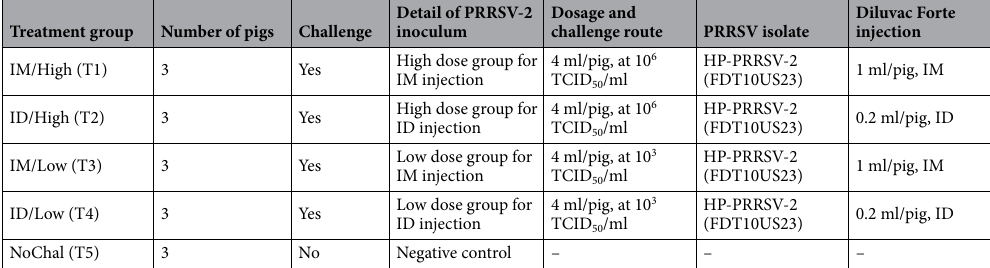
Table 2. Twenty-seven remaining pigs were left as non-challenge, age-matched sentinel pigs. Two different dos- ages of HP-PRRSV-2 were used to inoculate pigs. The IM/High (T1) and ID/High (T2) groups were intranasally inoculated with 4 ml (2 ml/nostril) of HP-PRRSV-2 (FDT10US23 isolate, 10 6 TCID 50 /ml). The IM/Low (T3) and ID/Low (T4) groups were intranasally inoculated with 4 ml of HP-PRRSV-2 at a lower dose (FDT10US23 isolate, 10 3 TCID 50 /ml). The NoChal (T5) group was served as a control, and the remaining 17 pigs were used as age-matched sentinel pigs. Sera were collected at 0, 7, 14, 21, and 28 DPC and assayed for the presence of PRRSV-specific antibody and RNA using ELISA and qPCR, respectively. To mimic vaccine administration, Diluvac Forte, an adjuvant, was used instead of a vaccine. At 7 DPC, the IM/High (T1) and IM/Low (T3) groups were IM injected with 1 ml of Diluvac Forte (batch no G197A01, MDS Animal Health, Boxmeer, The Netherlands) using a conventional needle (G18, 1 ″ ). The ID/High (T2) and ID/ Low (T4) groups were ID injected with 0.2 ml of Diluvac Forte using IDAL 3G needle-free vaccinator (MSD Animal Health, Boxmeer, The Netherlands). The same conventional needles or needle-free device were used to inject the same volume of Diluvac Forte (MSD Animal Health, Boxmeer, The Netherlands) to sentinel pigs with the same route of injection. The same device that was used to inject Diluvac Forte to one infected pig were used to administer Diluvac Forte into 2 sentinel pigs. The NoChal group was left as a negative control. Blood samples were collected from sentinel pigs at 0, 7, 14, 21 and 28 days post-injection (DPI). Injected sentinel pigs were weekly measured PRRSV-specific antibody and PRRSV RNA using ELISA and qPCR, respectively. Clinical evaluation. Clinical signs were monitored daily post-vaccination and post-challenge periods for two consecutive weeks by the same person at the same time. The severity of clinical respiratory disease for each pig was evaluated using a scoring system following stress induction as previously described criteria 39 : 0 = normal, 1 = mild dyspnea and/or tachypnea when stressed, 2 = mild dyspnea and/or tachypnea when at rest, 3 = moderate dyspnea and/or tachypnea when stressed, 4 = moderate dyspnea and/or tachypnea when at rest, 5 = severe dysp- nea and/or tachypnea when stressed, and 6 = severe dyspnea and/or tachypnea when at rest. Clinical sample collection. Blood was collected from pigs in serum separation tubes (Monovette, Sarstedt, Numbrecht, Germany) and centrifuged at 2000 × g for 10 min at 20 °C. Sera were stored in 1 ml aliquots at − 80 °C until used. Nasal swabs, tonsils, and feces were collected using individually packaged sterile swabs which were placed in Dulbecco’s modified eagle’s medium (DMEM, Gibco, MA, USA) supplemented with 5 × antibiot- ics (100 × Antibiotic-antimycotics, Gibco, MA, USA). Tonsils and feces were weighed and mixed with DMEM medium (10% weight by volume). Then, samples were homogenized and centrifuged at 4000 × g for 10 min. Homogenates were filtered through 0.2 μm pore size filters, treated with 5 × antibiotics overnight at 4 °C, and kept at − 80 °C until used. Urines were collected from bladders (10 ml/pig), filtered through 0.2 μm pore size filters, and kept at − 80 °C until used. Bronchoalveolar lavage (BAL) was performed aseptically at necropsy as previously described 40 . In brief, 50 ml of lavage fluid consisting of DMEM with 5 × antibiotics was gently dis- pensed and aspirated several times into the lungs. The BAL was kept at -80 °C until used. Antibody detection. PRRSV-specific antibodies were measured using a commercial ELISA kit (IDEXX PRRS X3 Ab test, IDEXX Laboratories Inc., MA, USA). The assay was performed following the manufacturer’s recommendation. Sera were considered positive for PRRSV antibody if the S/P ratio was greater than 0.4. Peripheral blood mononuclear cells (PBMC) isolation. Peripheral blood mononuclear cells (PBMC) were isolated from heparinized blood using gradient density centrifugation (Lymphosep, Biowest, MO, USA) as previously described 26 . Isolated PMBC were counted by an inverted microscope, and concentrations were accessed in cRPMI-1640 [RPMI-1640 media supplemented with 10% fetal bovine serum (FBS), 2 mM L-glu- tamine, and 50 μg/ml of gentamycin]. The viability of isolated PBMC was determined by Trypan blue (Sigma-